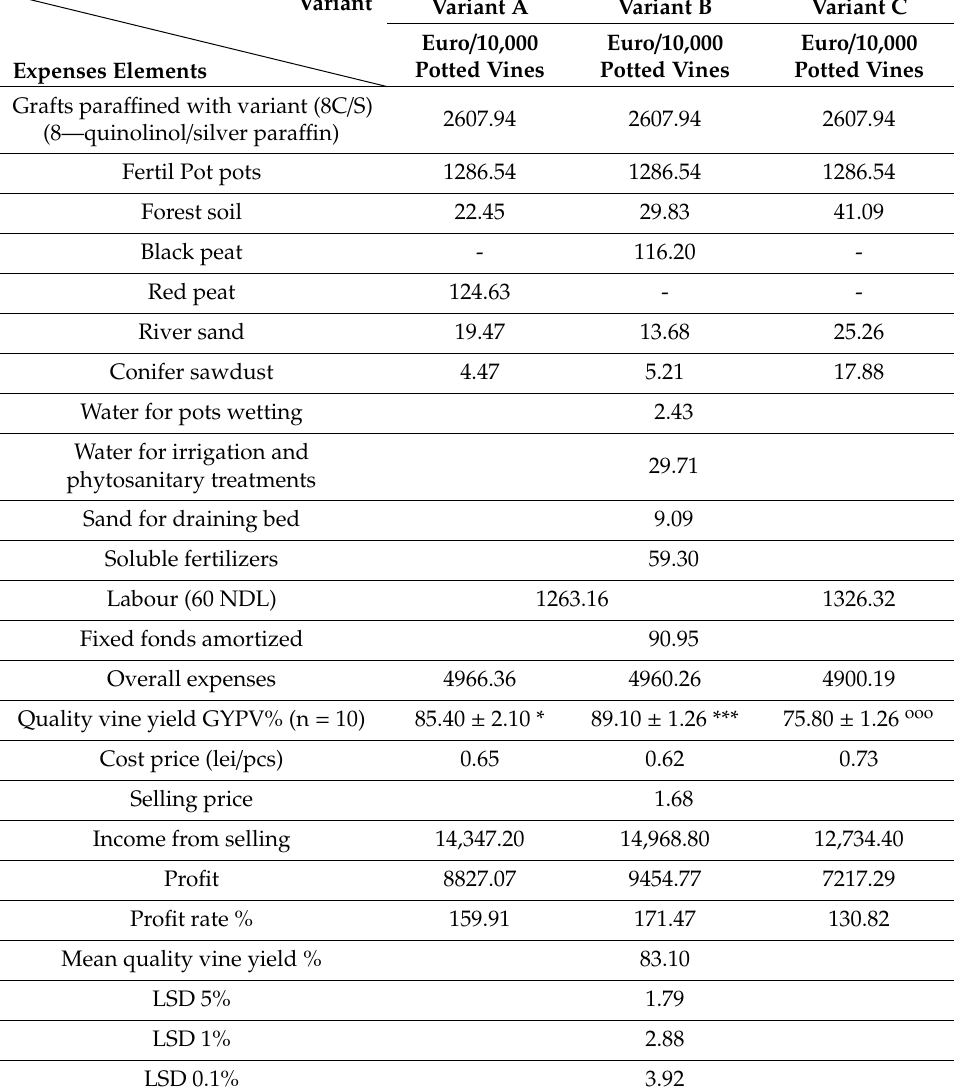
Table 6. Economic data of potted